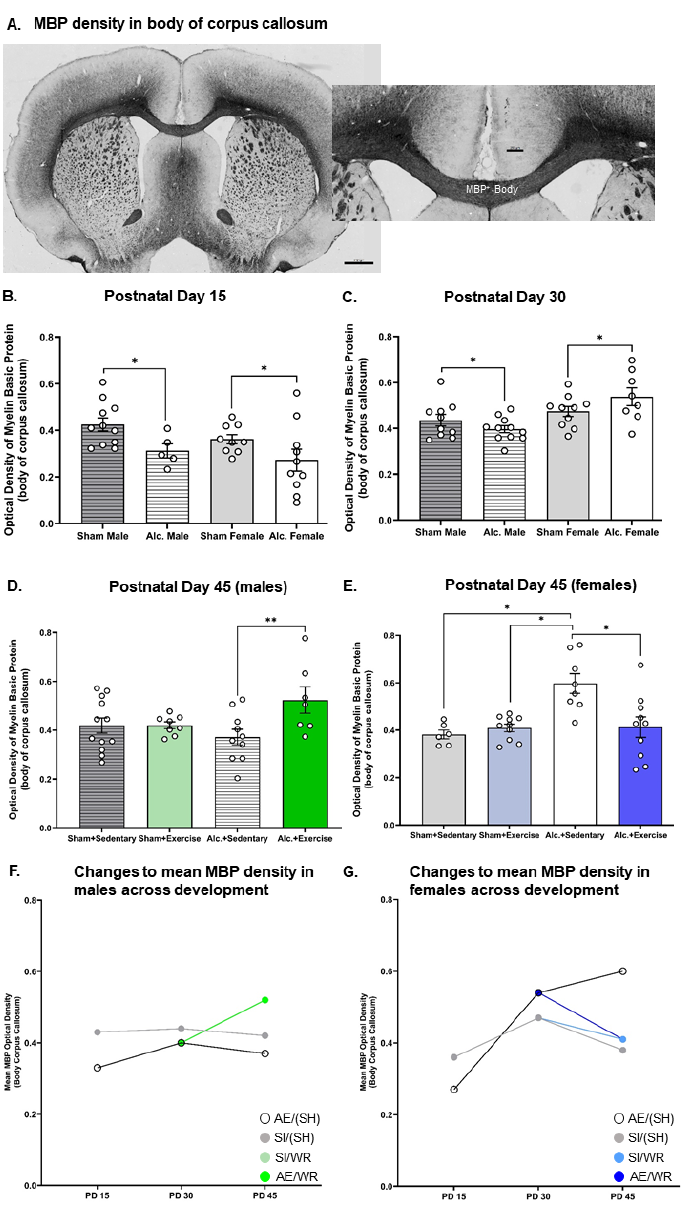
Figure 4. Densitometric analysis of MBP in the body of CC from PD 15 to 45. ( A ) Example of histological staining used to visualize MBP in corpus callosum, scale bar = 1–2 mm; ( B , C ) Comparison of the optical density of MBP in the body of CC in brain tissue extracted from AE and SI rats from both sexes; ( D , E ) Comparison of the optical density of MBP in the body of CC in SI/SH, SI/WR, AE/SH, and AE/WR male ( D ) and female ( E ) rats. Each data point in graphs ( B – E ) represents the mean estimate per rat and error bars represent ± SEM, * p ≤ 0.05, ** p ≤ 0.01; ( F , G ) Trajectories of MBP production across all time points in the male ( F ) and female ( G ) brain in all postnatal treatment and intervention